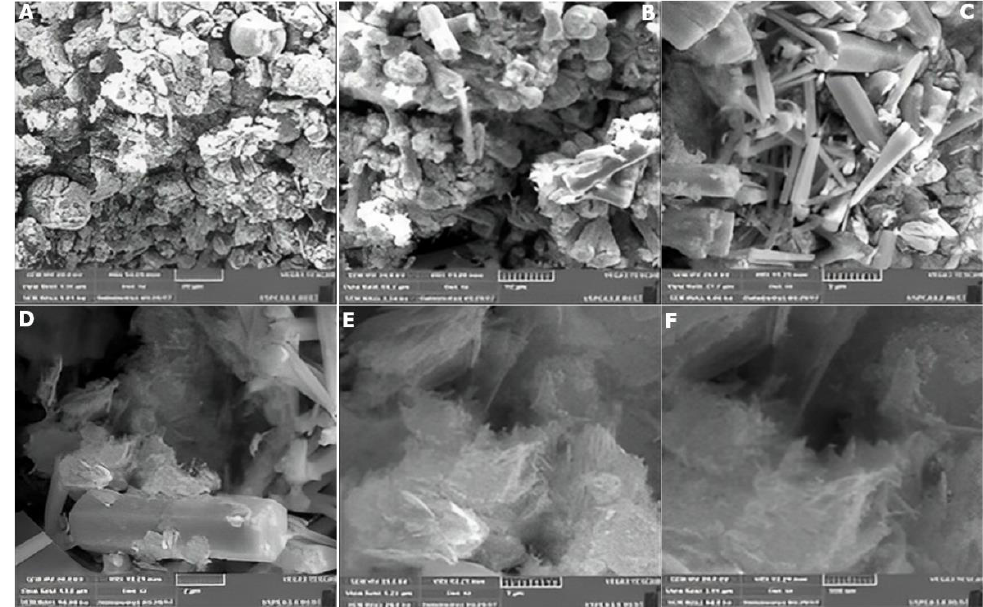
Figure 12. SEM images of ZnO/CNTs nanocomposites synthesized by the CBD method (( A )—20 µm, ( B )—10 µm, ( C )—5 µm, ( D )—2 µm, ( E )—1 µm, ( F )—0.5 µm).